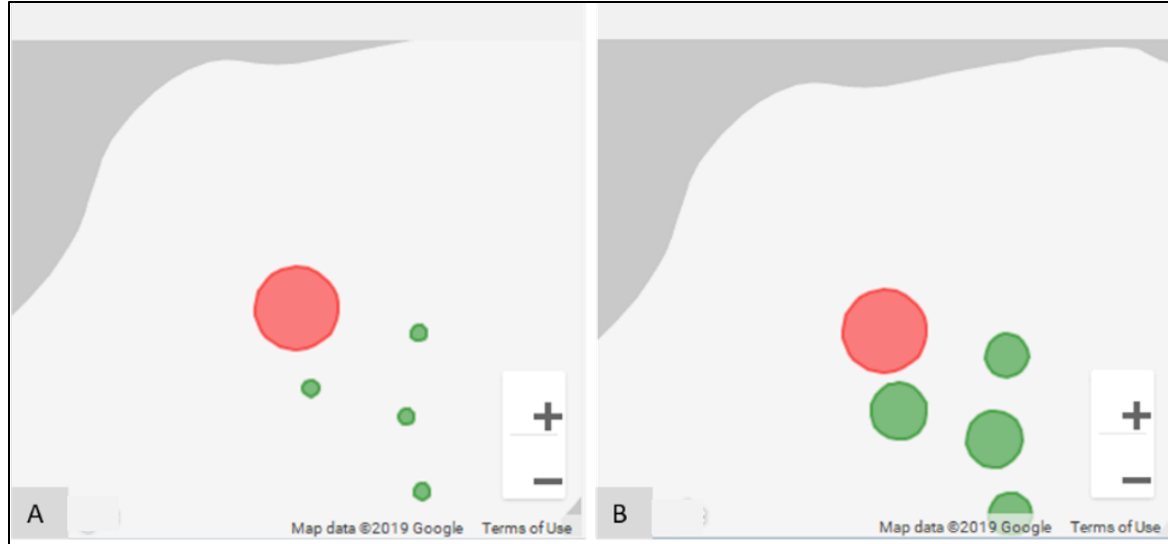
Figure 11. Proportional symbol map for July 2017 for M neighborhood for: ( A ) FC count; ( B ) environment variable, “water” .